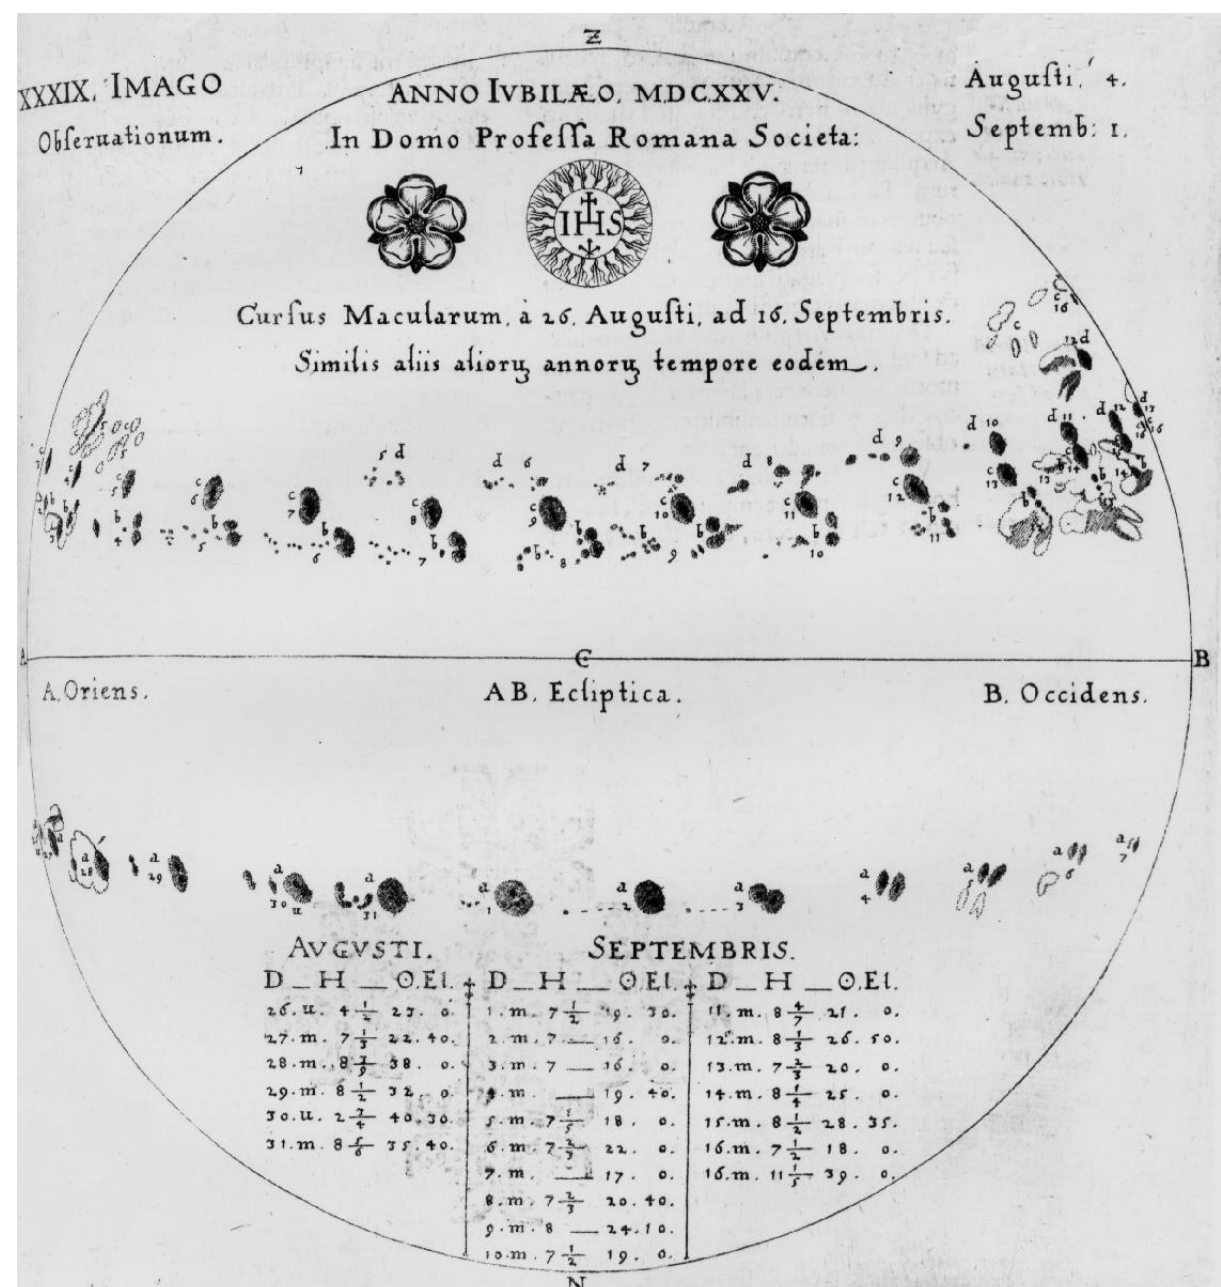
Fig. 2. The daily progression of sunspots across the solar disk during the interval AD 1625 August 26–September 16 (Scheiner, 1630). The sunspot in the southern half of the solar disk was close to the central meridian on September 2 and large enough to be seen without the aid of a telescope, which confirms the unaided-eye Chinese sunspot observation on the same date (see Table 1).